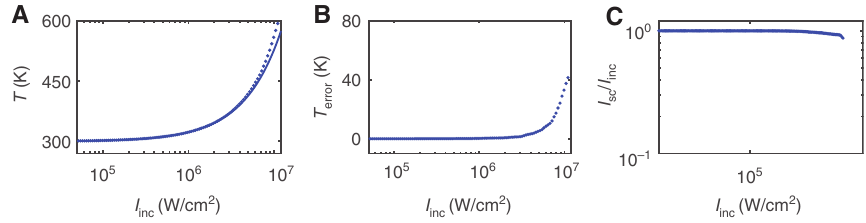
= 5.5) for the TDP model (blue dots) and TIP model (solid blue line) d